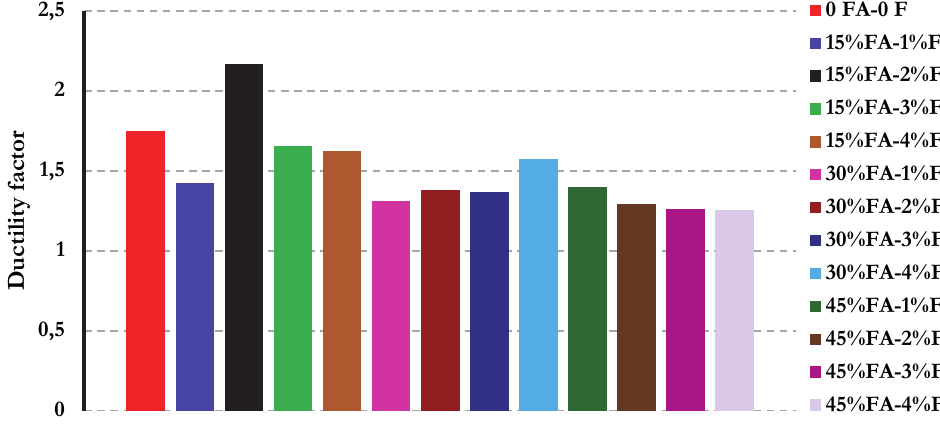
Figure 8: Ductility factor for all specimens